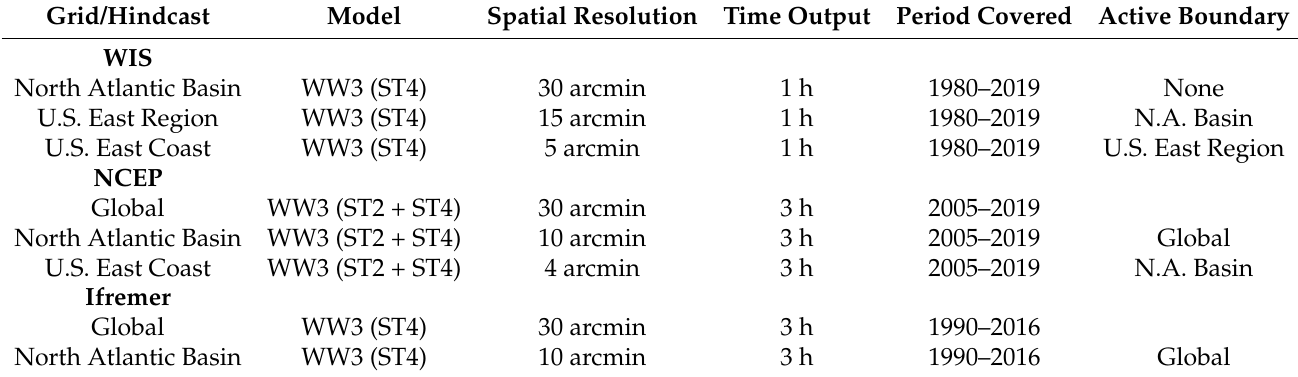
Table 2. Hindcast models, grid resolutions, temporal output resolution, period covered, and boundary conditions.